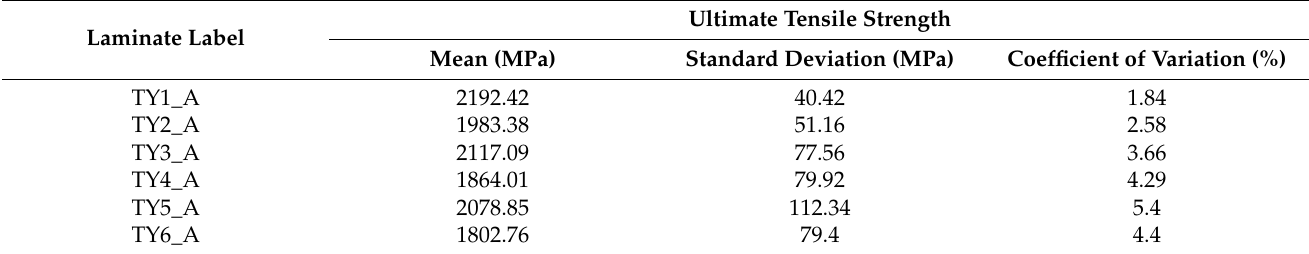
Table 3. Ultimate tensile strength for different batches of specimens.